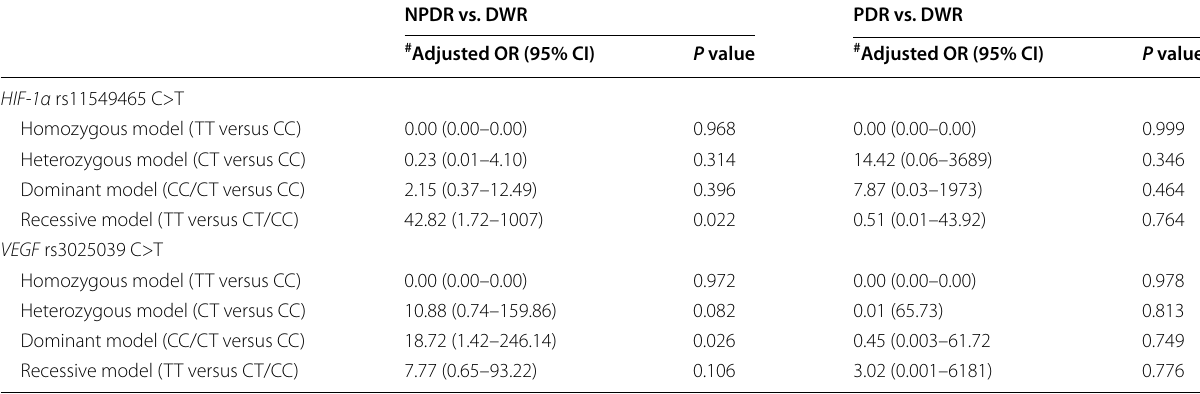
Table 4 Association of HIF-1α and VEGF variants with diabetic retinopathy risk according to genetic association models using binary logistic regression